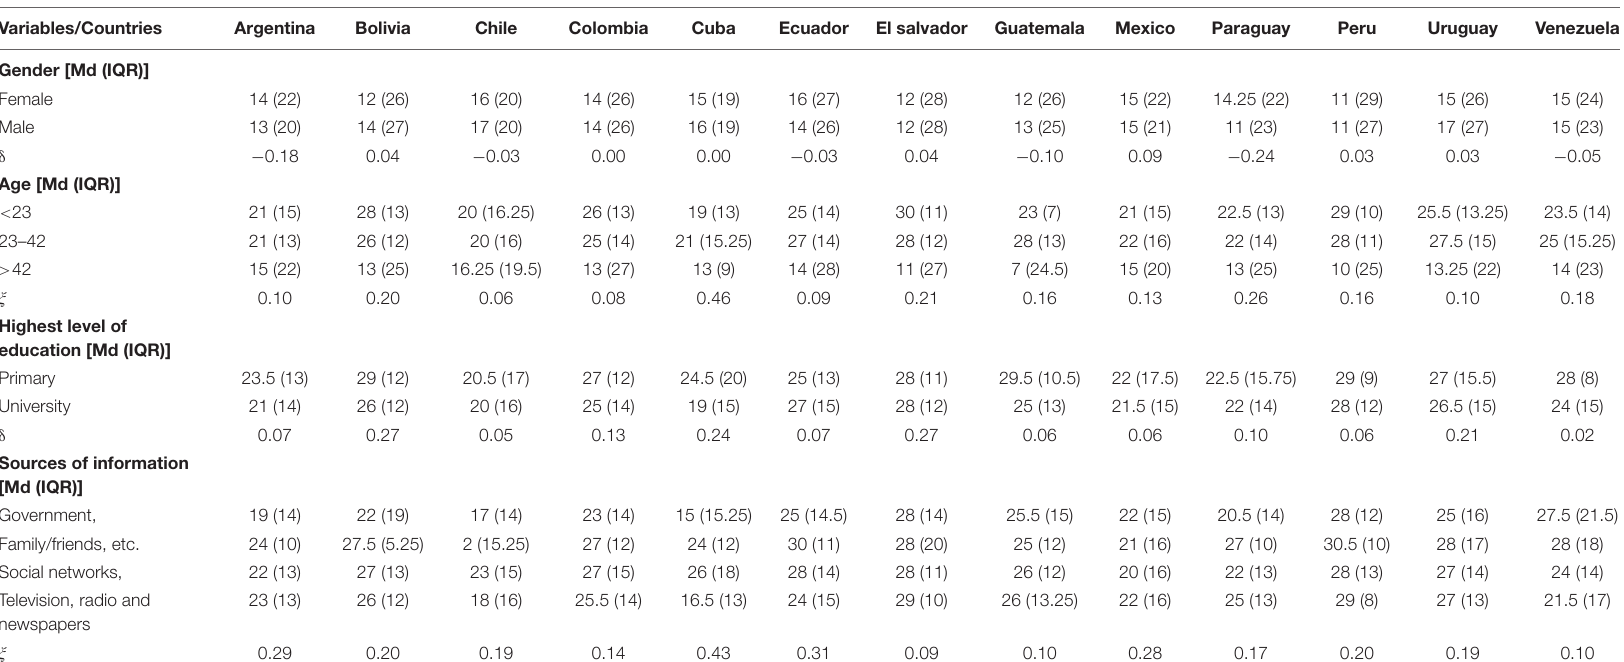
TABLE 2 | Descriptive statistics and effect